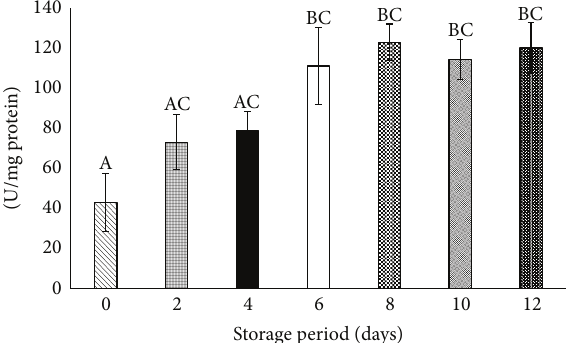
Figure 3: Superoxide dismutase in stored platelets. Values are mean ± SE of five animals/group. One-way ANOVA was performed betweenthegroupsfollowedbyTukey-Kramermultiplecomparison test, using Graph Pad Prism 6 software, and represented in upper case at 𝑃 < 0.05 . Those not sharing the same letters are significantly different.